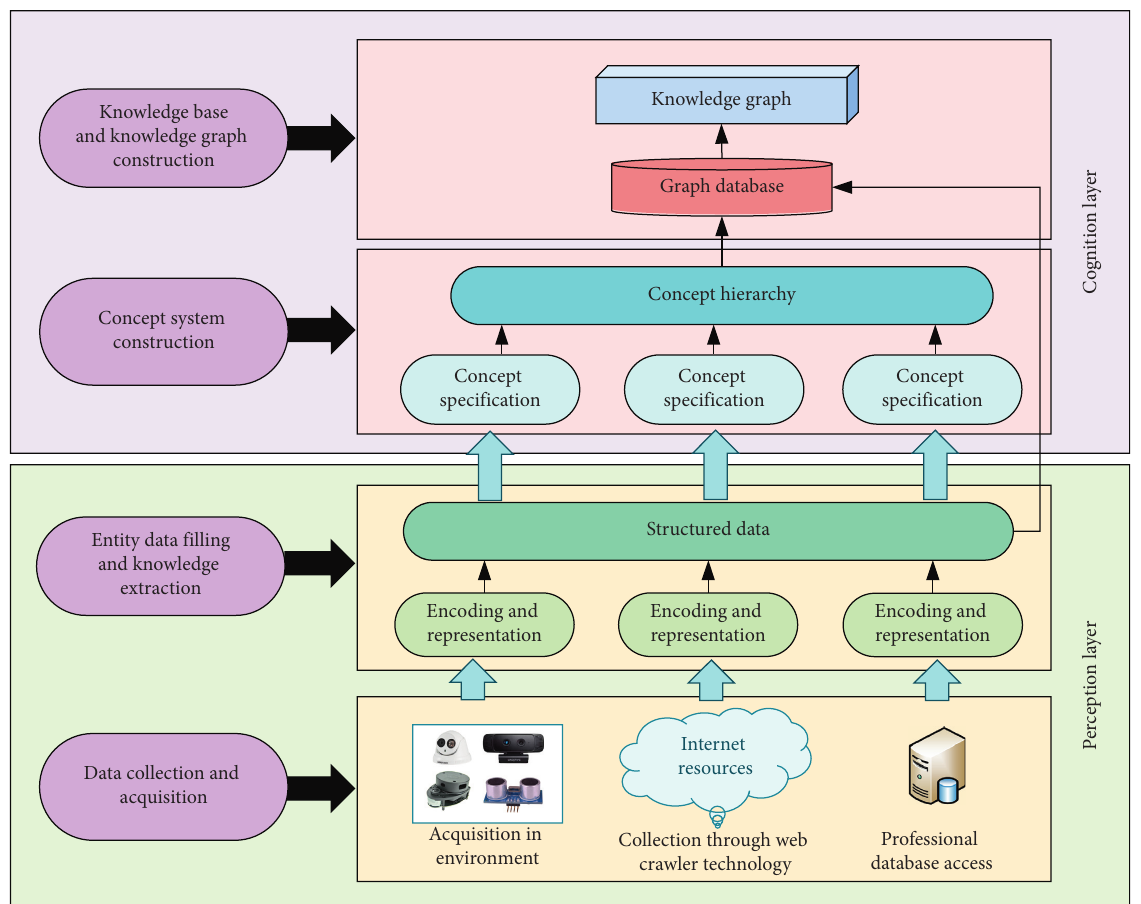
Figure 1: Flowchart of knowledge graph construction.